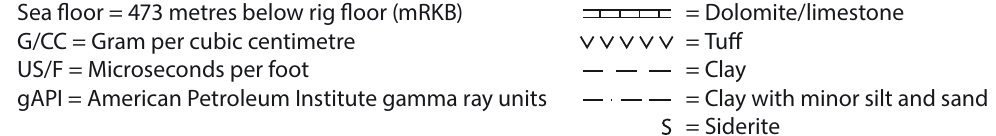
Figure 11. Well summary figure for well 7316/5–1 including resistivity log, density log, sonic log, gamma-ray log, lithology, lithostratigraphic units, sub-series, and paleobathymetry for the lowest part of the supplementary well Fig. 11 reference sections for the Torsk Formation (lower–middle Eocene to middle Eocene; modified after NPD factpages (npd.